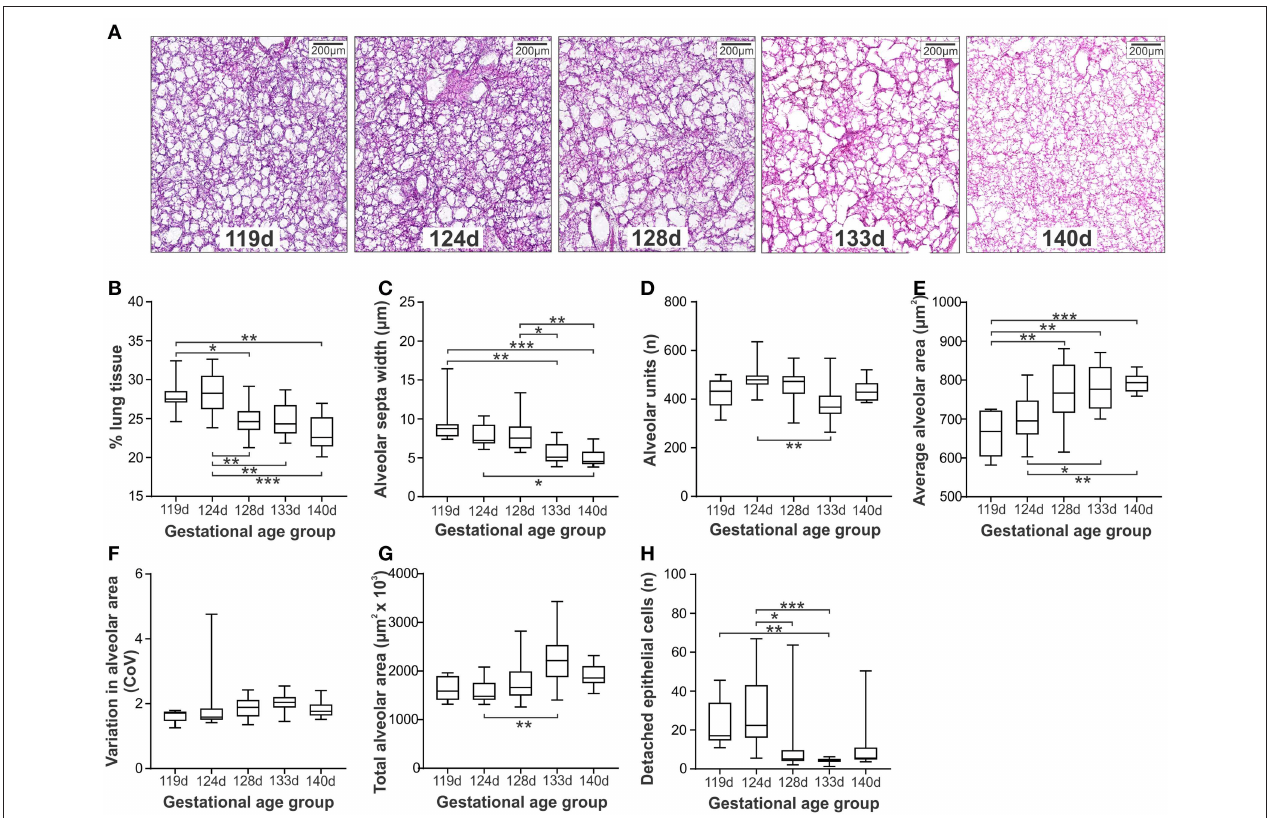
FIGURE 3 | Histological measures of lung injury in ventilated lambs at different gestations ( Study 2 ). Representative micrographs at gestations 119d to 140d (A) . Morphological assessments included; % lung tissue (B) , alveolar septa width (C) , number of alveoli per image (D) , average alveolar area (E) , variation in the alveolar area (F) , total alveolar area in each image (G) , and the number of detached epithelial cells per image (H) . The boxes encompass the 25th to 75th percentiles and line within the box the median. Whisker caps denote the maximum and minimum values. * P < 0.05, ** P < 0.01, *** P < 0.001 as determined by parametric or non-parametric ANOVA as appropriate [one-way ANOVA; (B,E) or Kruskall-Wallis ANOVA; (C,D,F–H) with post hoc testing to identify intergroup differences (Tukey’s post hoc test or Dunn’s multiple comparison test,